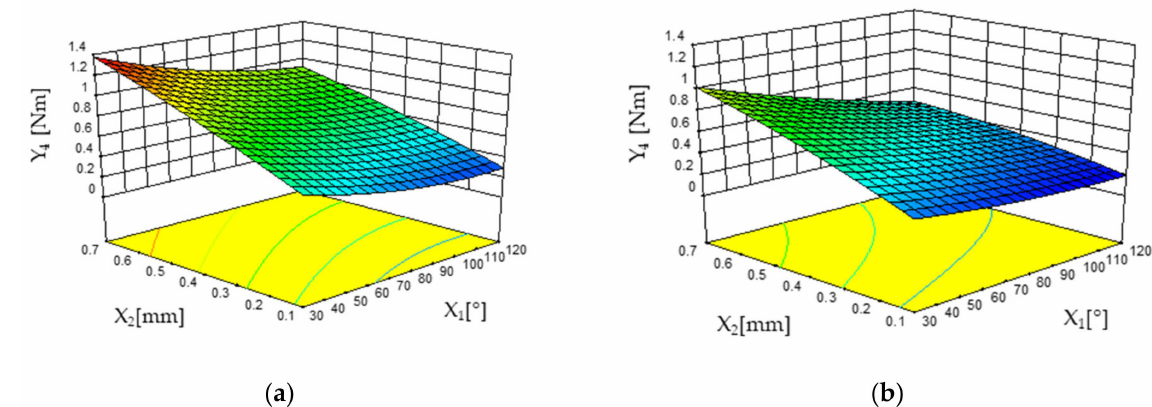
Figure 6. The 3D plots showing interaction effects of the drill tip angle (X 1 ) and tooth bite (X 2 ) on the drilling torque (Y 4 ) when the holes were ‘performed’ with a flat drill ( a ) and with a helical drill ( b ). To reveal the optimal value of analyzed factors, the criteria that are presented in Table 9 were specified as input values of the optimization algorithm, which is used by the Design Expert software. The solutions with the highest desirability coefficient were selected as the optimum value of the analyzed factors both in the case of a helical or a flat drill. The optimum solutions are presented in Table 10. To figure out the relative error of the selected regression equation, Equation (16) was applied. In this equation, the experimental value (Y) was considered the mean of measured response, and was considered taken from the employed data set: